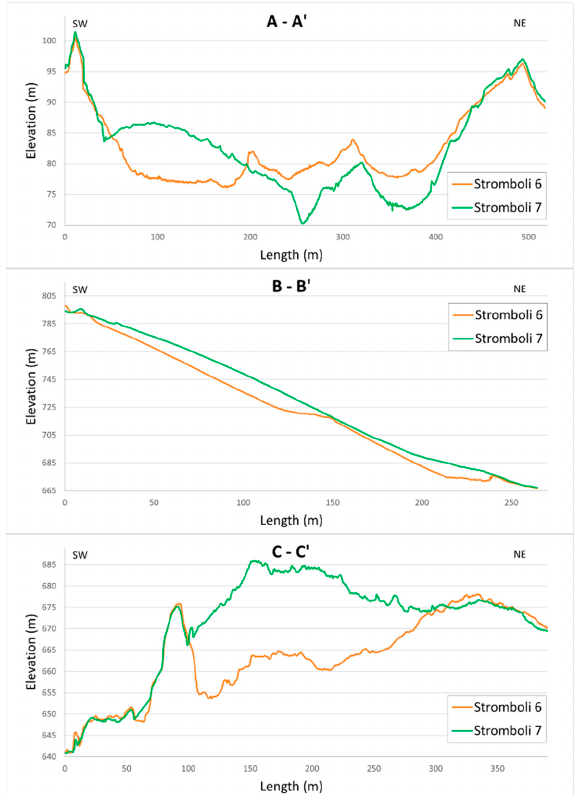
Figure 8. Cross-section across portion of the Sciara del Fuoco along profiles represented in Figure 7. Stromboli 6 and Stromboli 7 are the DSMs generated by the UAV-based photogrammetric survey carried out in June 2019 and July 2021, respectively. Table 4. Events occurred at Stromboli volcano between June 2019 and July 2020. The position of South West Crater (SWC) and North East Crater (NEC) is shown in Figure 1.